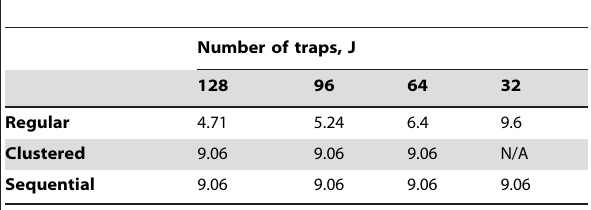
Table 1. Trap spacing (km) for each combination of trap configuration (regular, clustered, and sequential) and number of traps (J= 128, 96, 64, and